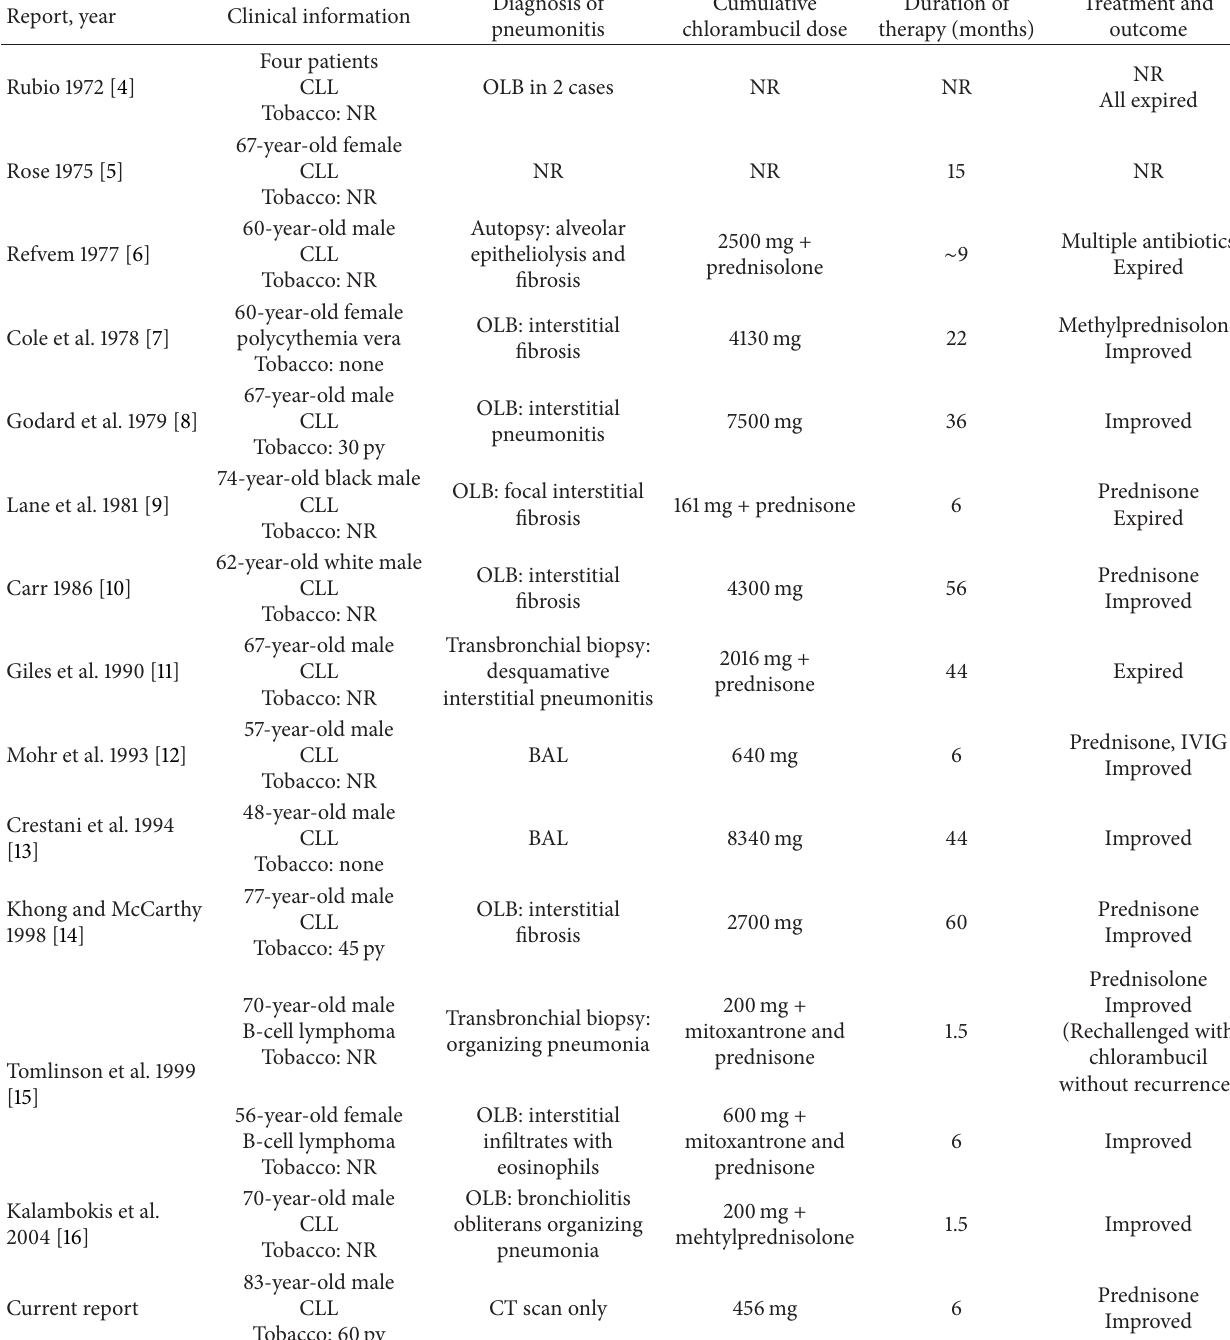
Table 1: Reports of chlorambucil-induced interstitial lung